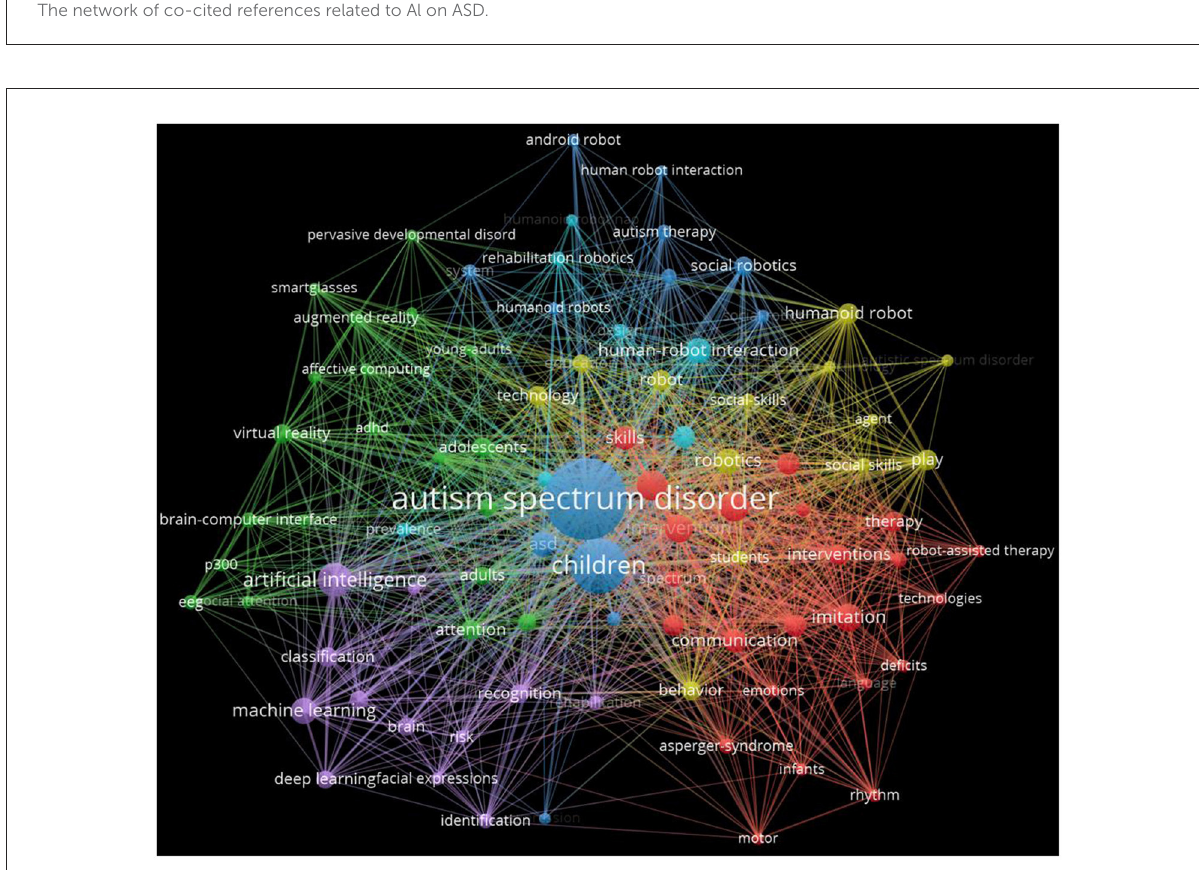
FIGURE9 The network of co-occurence keywords related to Al on